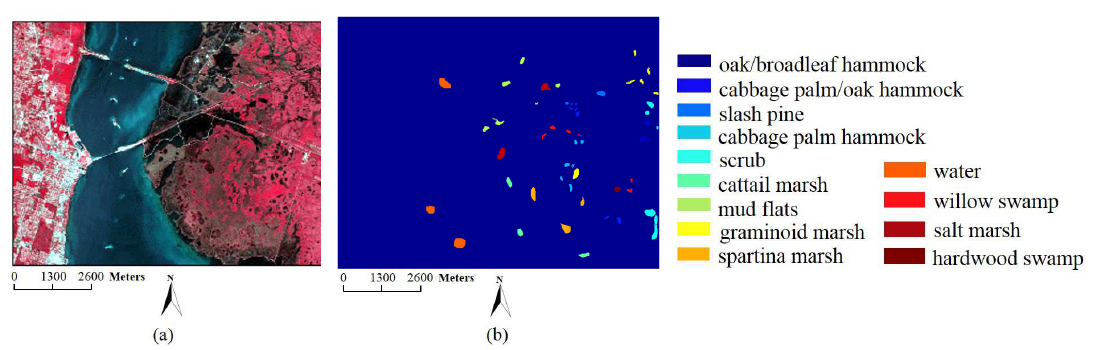
Figure 5. KSC data. ( a ) Three band false color composite and ( b ) ground truth data with 13 classes.